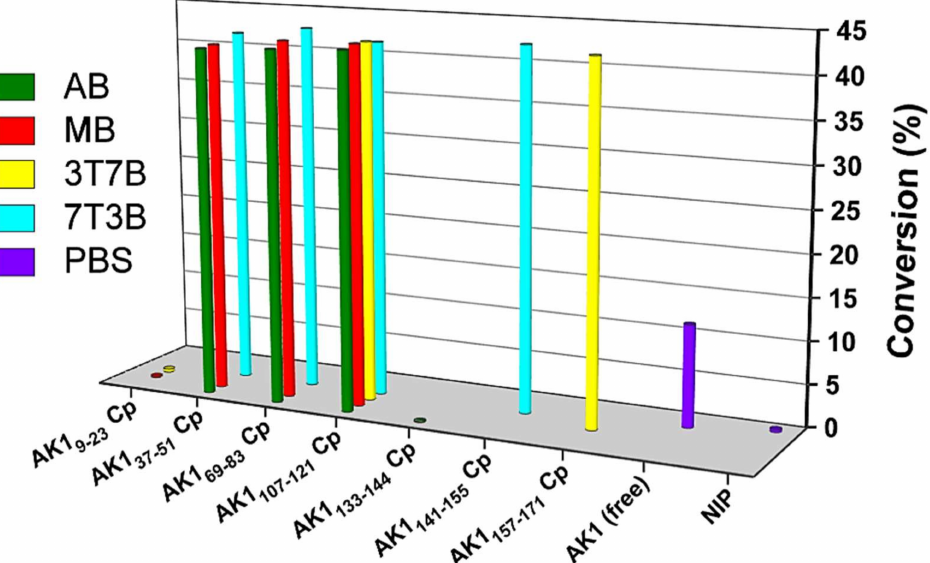
Figure 4. The effect of integrating a conformation tie into AK1’s catalytic activity. Cp, chip; NIP, non-imprinted polymer. Buffer: pH 7.2, 20 mM PBS buffer; AB, CH 3 CN/buffer = 1:1; MB, CH 3 OH/buffer = 1:1; 3T7B, TFE/buffer = 3:7; 7T3B, TFE/buffer =